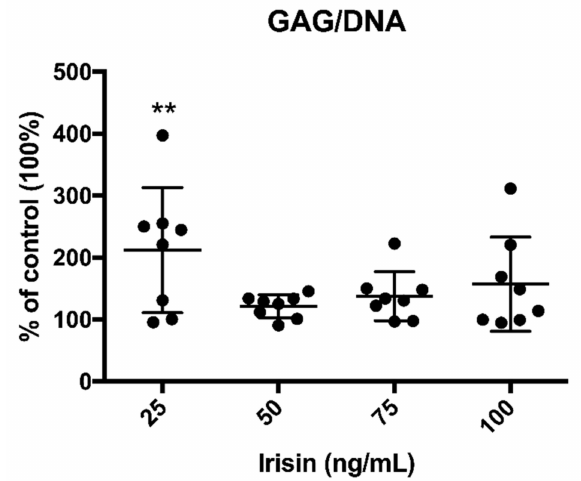
Figure 1. Irisin increases glycosaminoglycan (GAG) content in treated human osteoarthritic chondrocytes (hOAC). GAG / DNA content in hOAC after irisin treatment demonstrated a significant increase in the experimental group treated with 25 ng / mL. n = 8, ** p < 0.01 compared to the control group.